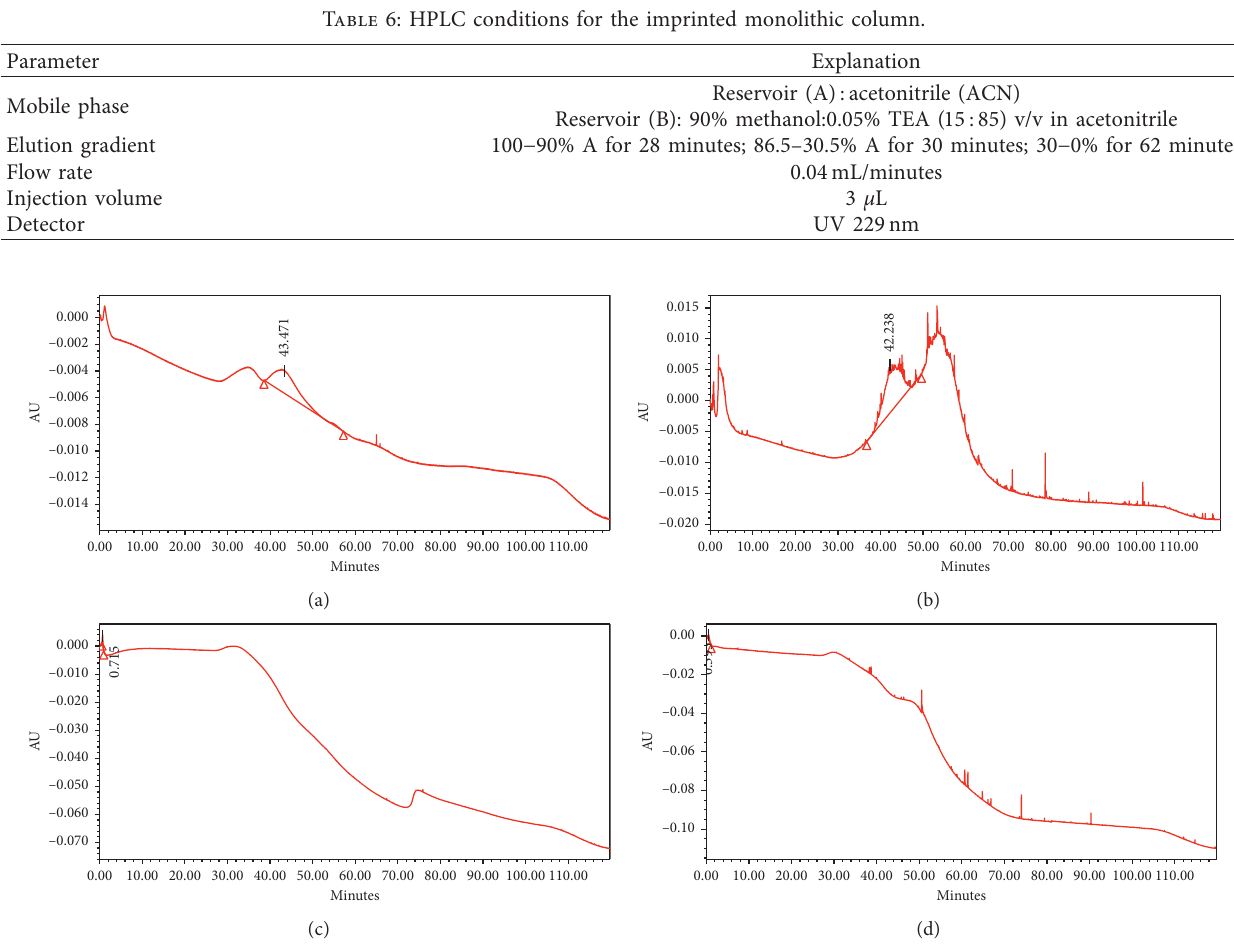
Figure 7: Chromatograms of atenolol standard solution using the monolithic imprinted column MIP 1 (a); MIP 2 (b); NIP 1 (c); NIP 2 (d). Table 7: Chromatographic profile of atenolol standard solution using the imprinted monolithic column. Monolithic